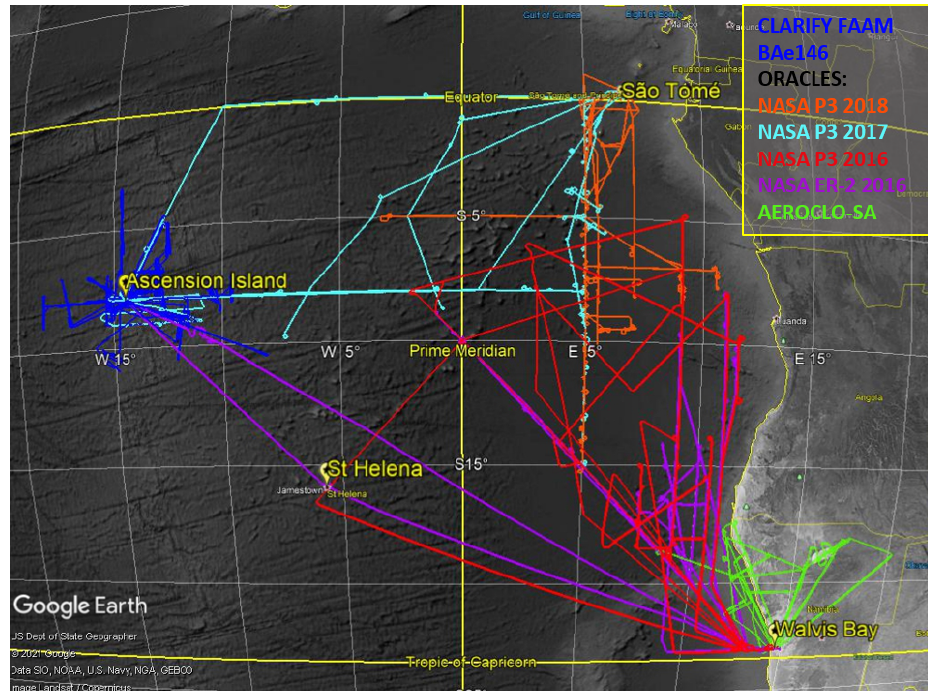
Figure 2. Flight tracks for science flights (transit and ferry flights omitted; ©Google Earth 2021) from CLARIFY 2017 (FAAM BAe-146); ORACLES 2016 (NASA P3 and ER-2), 2017 (P3) and 2018 (P3); and AEROCLO-SA